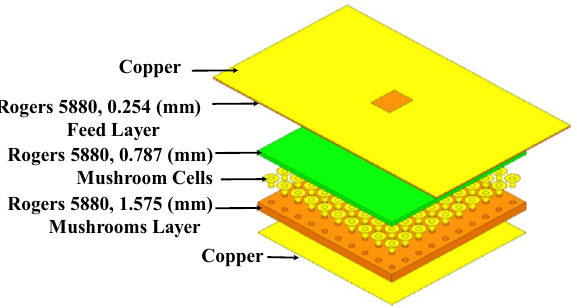
Figure 19. Slot excitation using printed ridge gap waveguide technology.